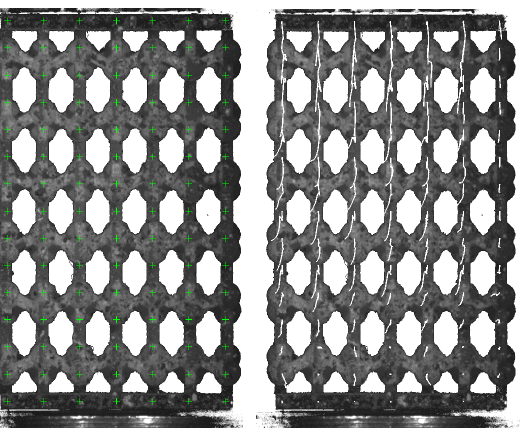
Figure 3. Loading scene with tracking features (left) and tracked displacement paths (right). Black back- ground was inverted due to a better